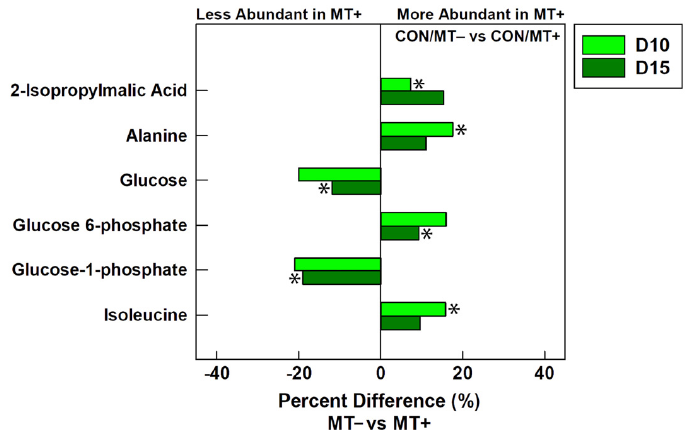
Figure 4. Average percent difference in discriminated metabolites between in cecal digesta of broiler chicks that were administered an unamended starter diet (CON) and received a microbiota transplant (MT+) or buffer alone (MT–). Samples were analyzed 10 days post-hatch (D10) and 15 days post-hatch (D15). Metabolites that were altered ( p ≤ 0.050) according to univariate Mann–Whitney analysis are denoted with an asterisk.